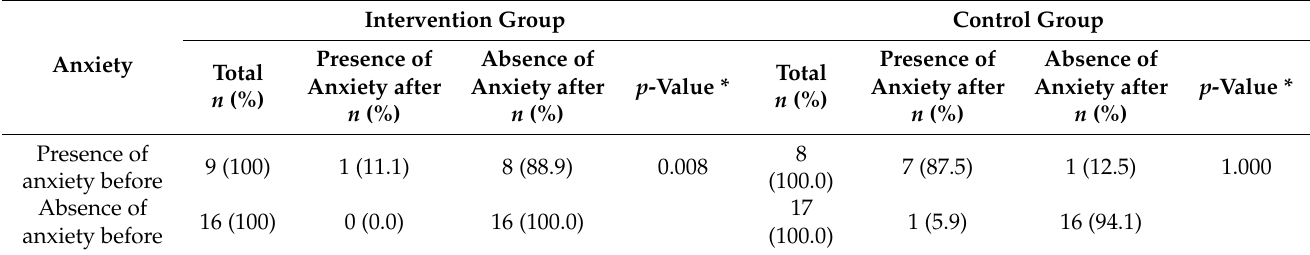
Table 5. Comparison of the level of anxiety before and after the intervention in the two groups.